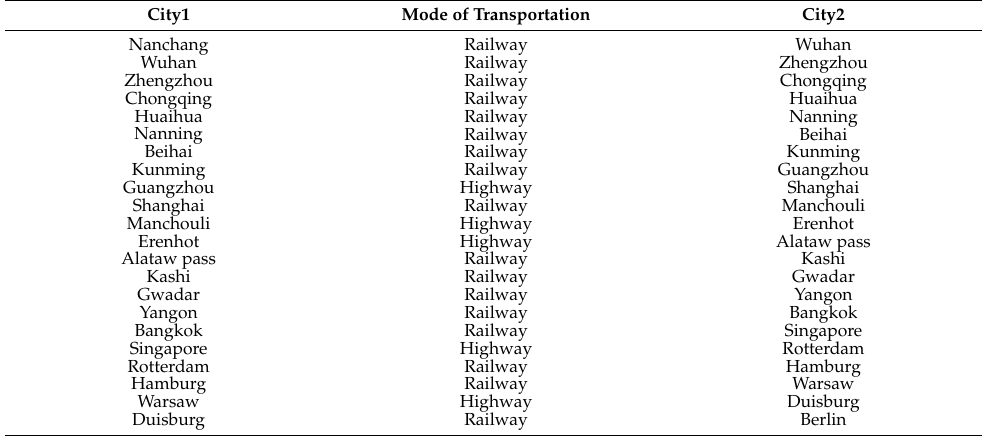
Figure 19. Optimization of Nanchang-Berlin multimodal transport network by FAGA algorithm. Table 10. Optimizing the optimal path of multimodal transport by the FAGA